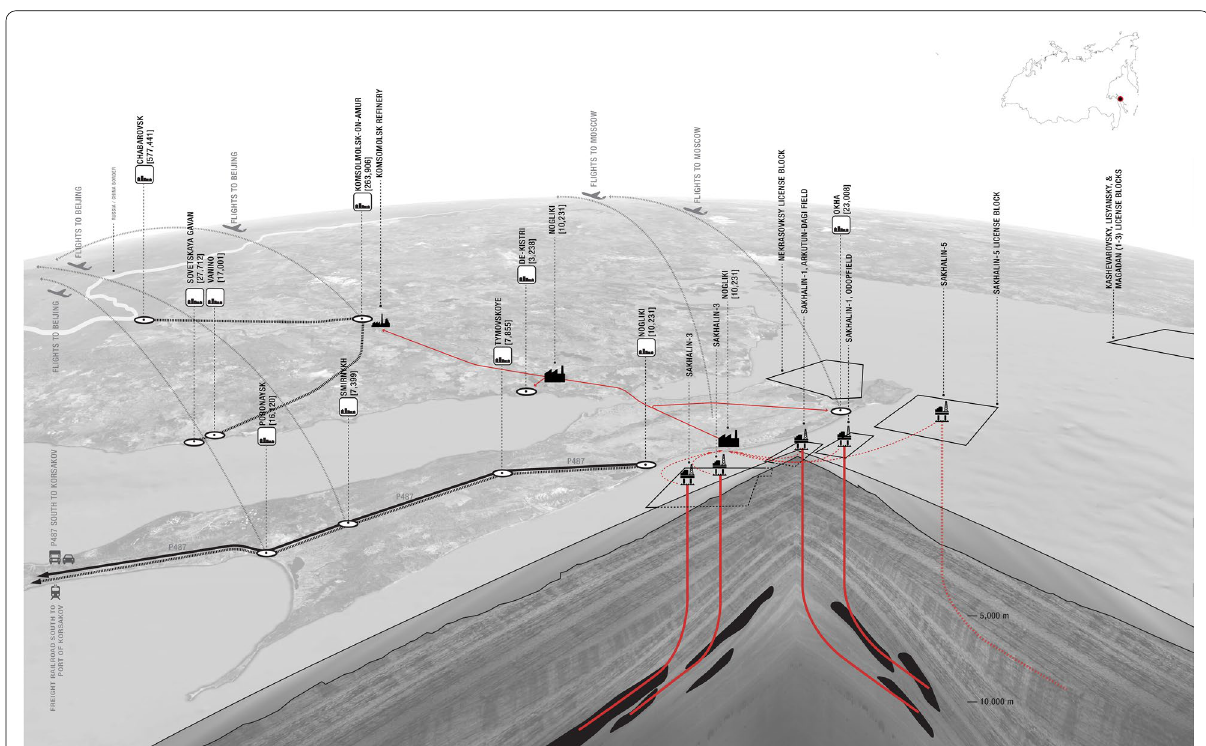
Fig. 5 Urban fabric of Sakhalin Island, showing the dissociation between settlements and areas of resource extraction, and the trans-scalar articulation of the extraction economies through systems of international transport. Image credits: Salgueiro Barrio and O’Shea. Refer Fig.